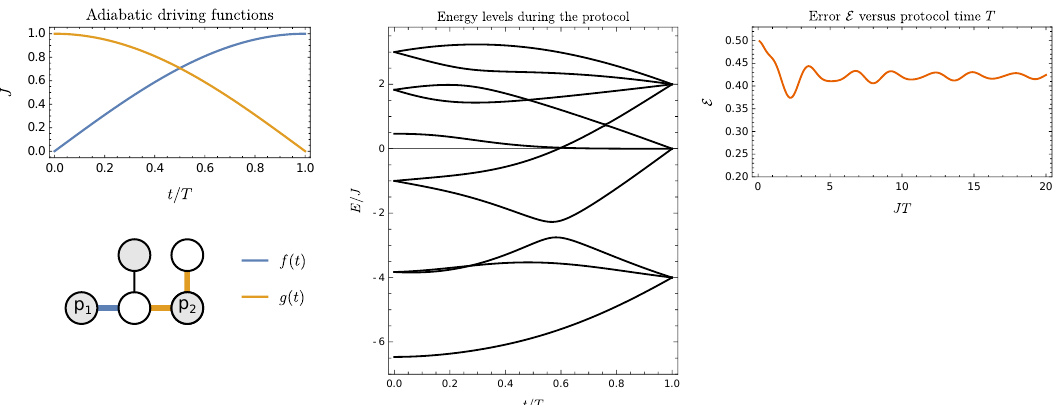
Figure 7: An example of a transfer protocol in which our requirements are